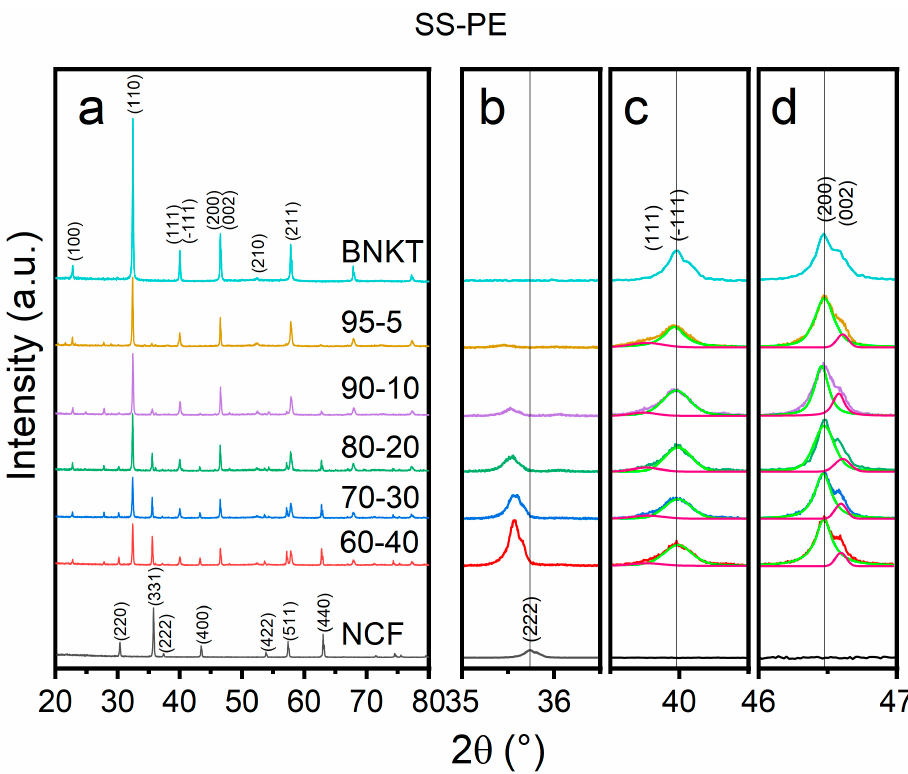
Figure 1. XRD patterns of the xBNKT-(100-x)NCF (x = 100, 95, 90, 80, 70, 60, 0) SS-PE composites ( a ). Enlargements of 35–36.5° ( b ), 39–41° ( c ), and 46–47° ( d ) angles.